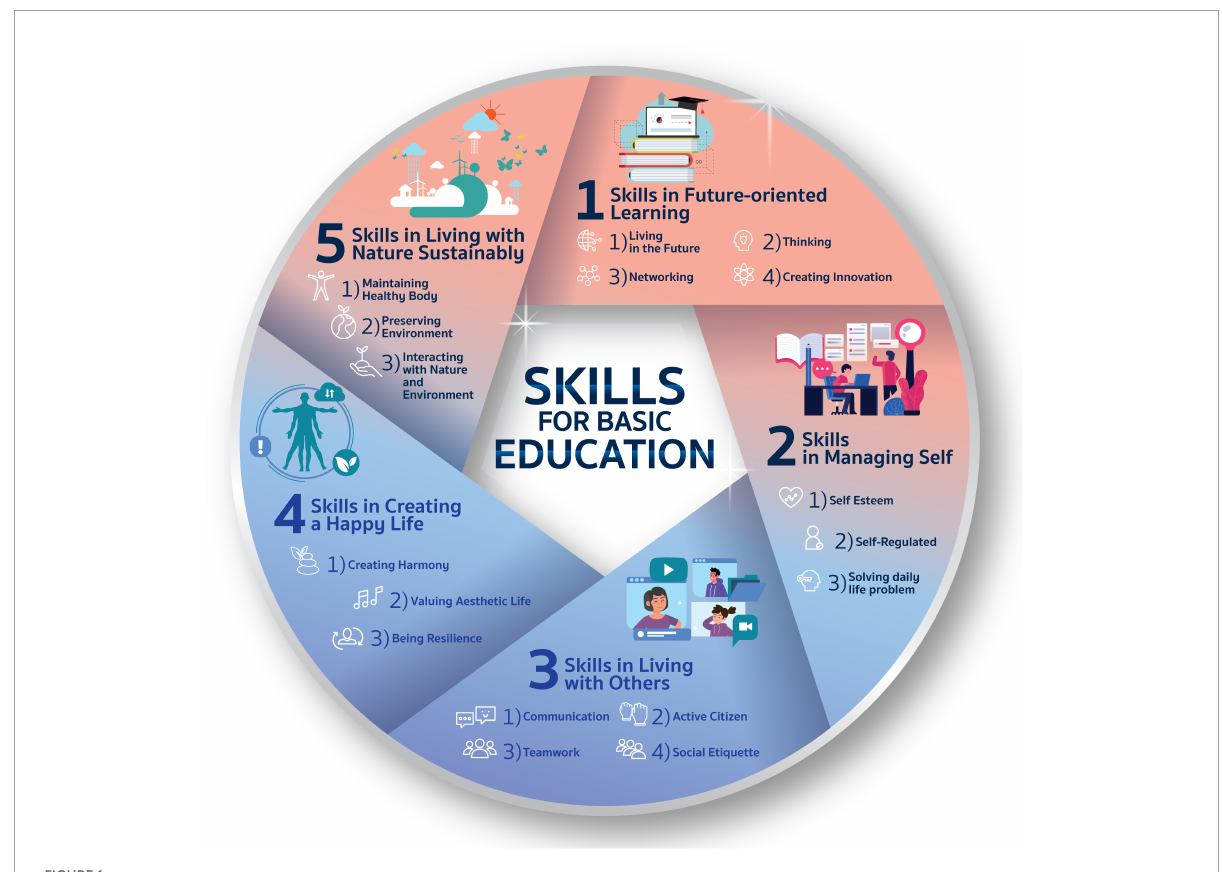
FIGURE1 Skills framework for students in basic education levels (Buasuwan et al.,